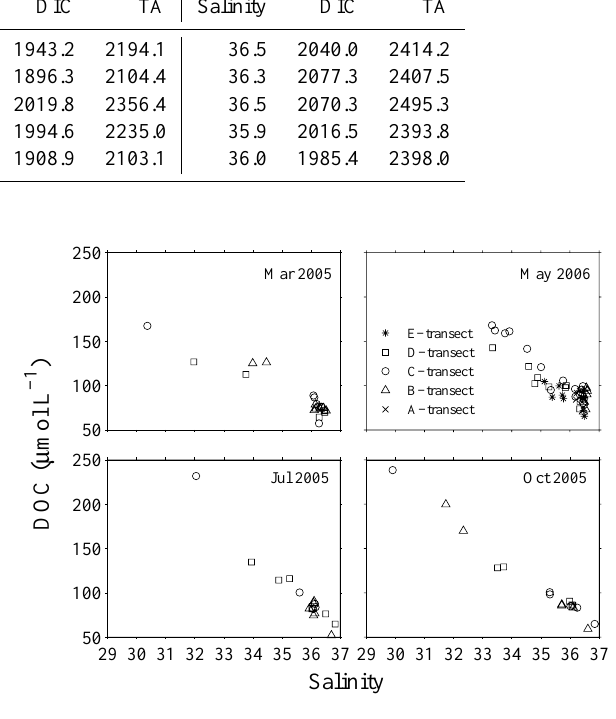
Fig. 4. Surface water dissolved organic carbon (DOC) vs. salinity in March, July, and October 2005 in the South Atlantic